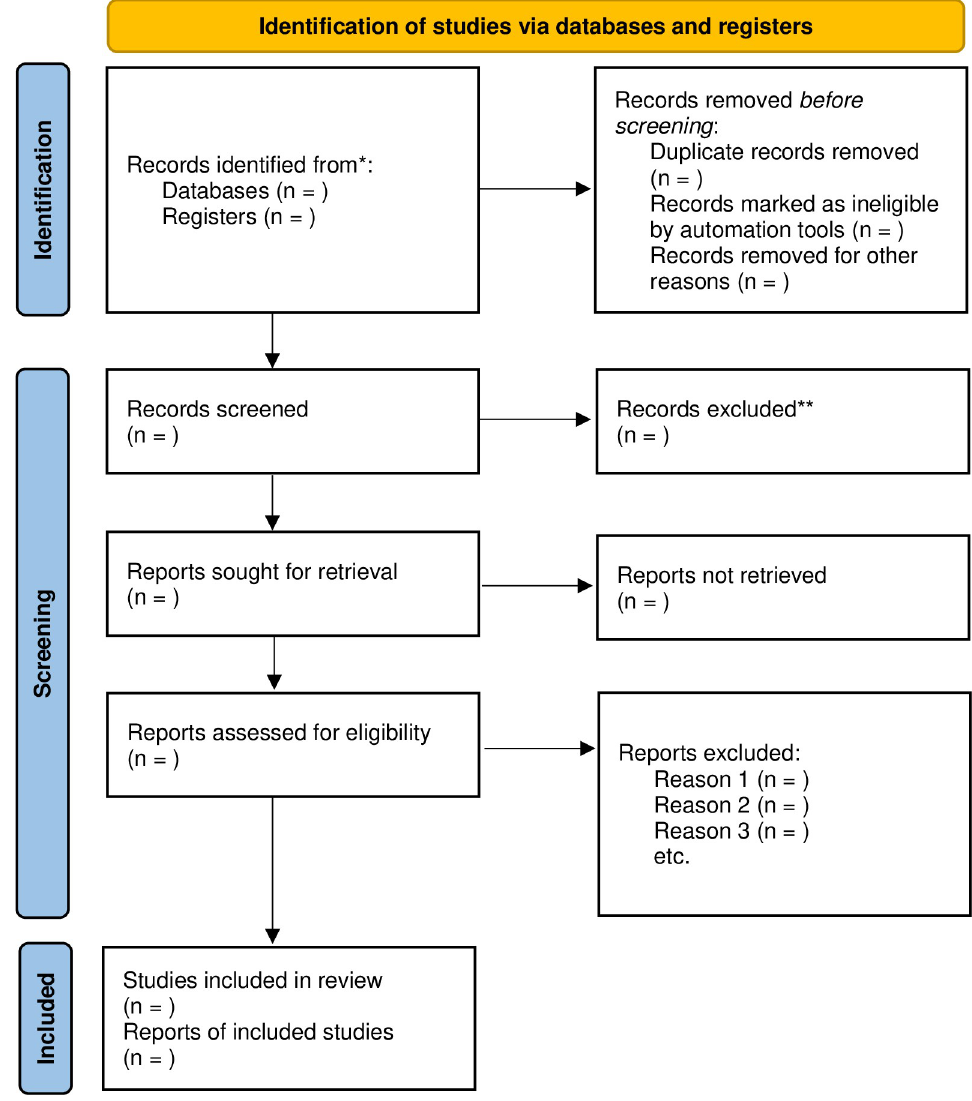
Fig 1. PRISMA flowchart for the study selection